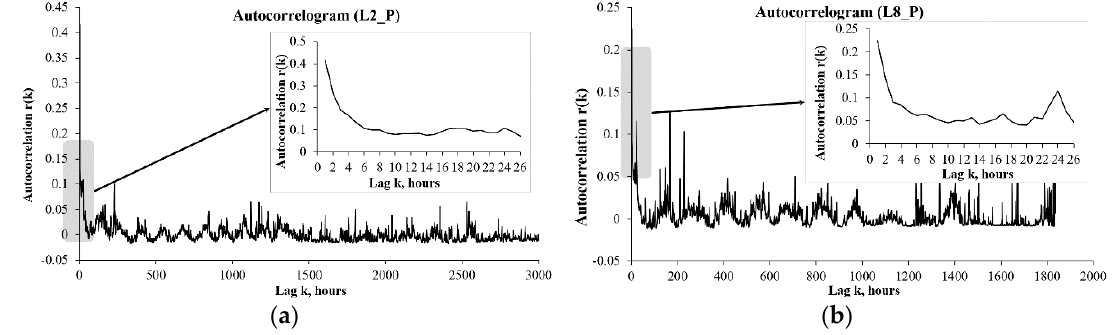
Figure 13. ( a ) Autocorrelogram for L2_P data; ( b ) autocorrelogram for L8_P data.